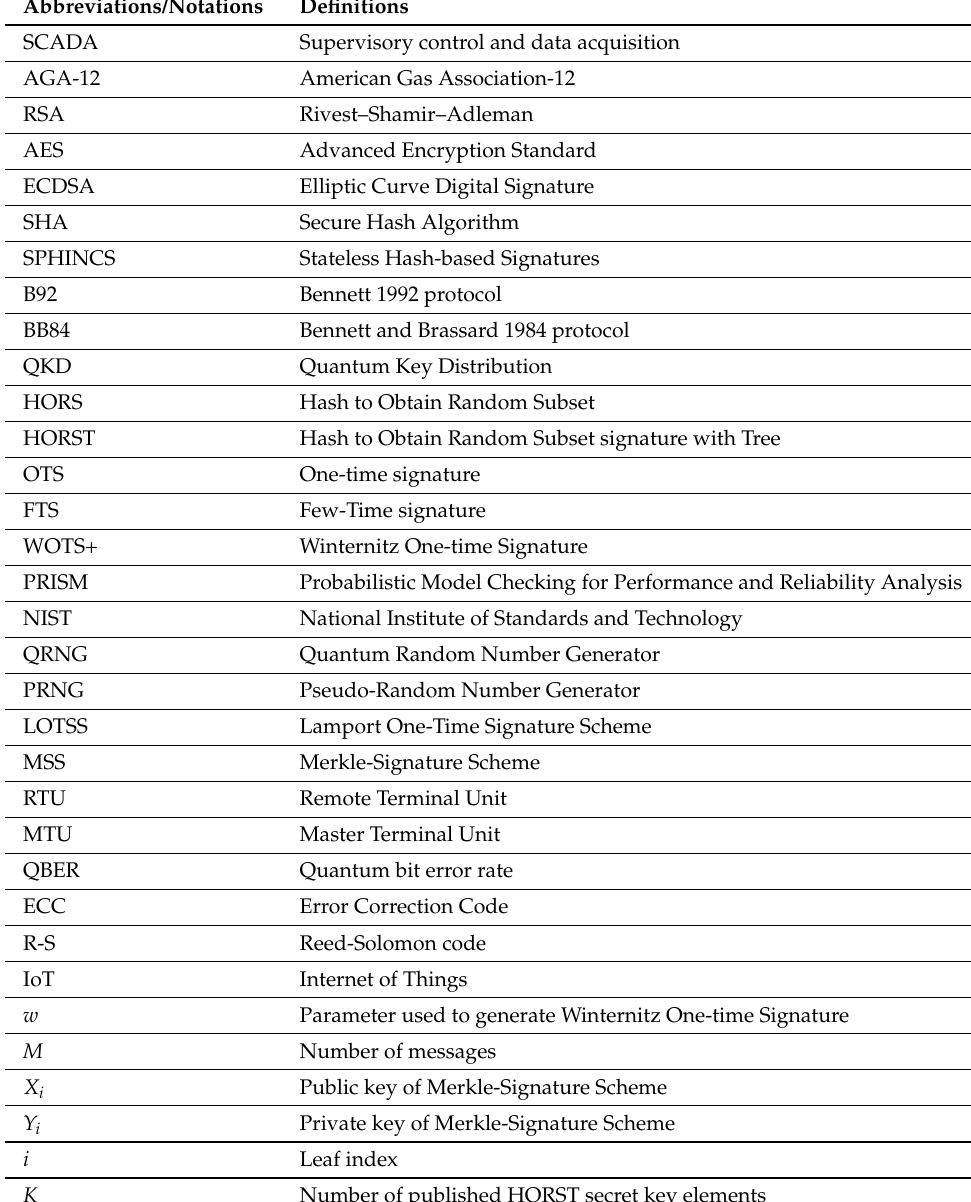
Table 1. List of Abbreviations and